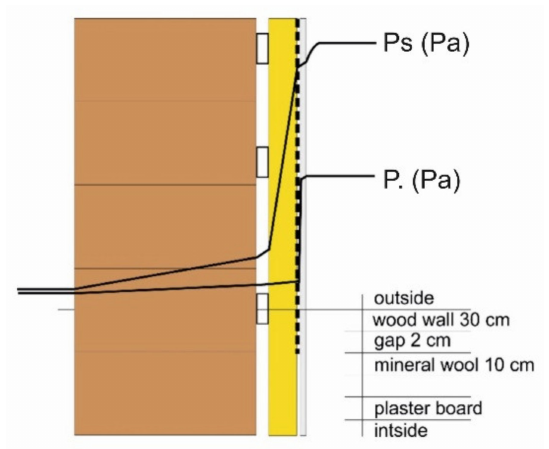
Figure 4. Cross section of a wall with traditional internal thermal insulation and actual vapour pressure charts P and saturated vapour pressure